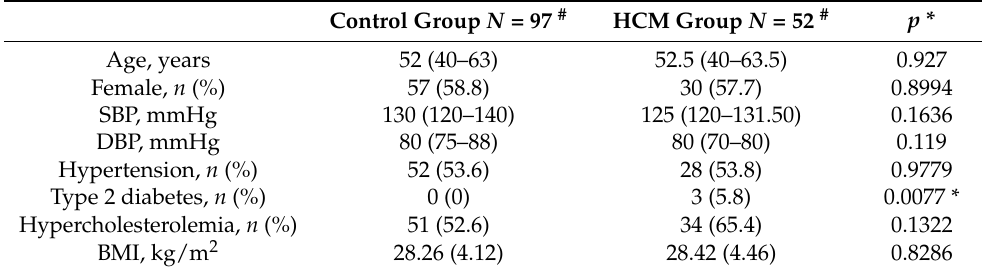
Table 1. Baseline characteristics of the patients.